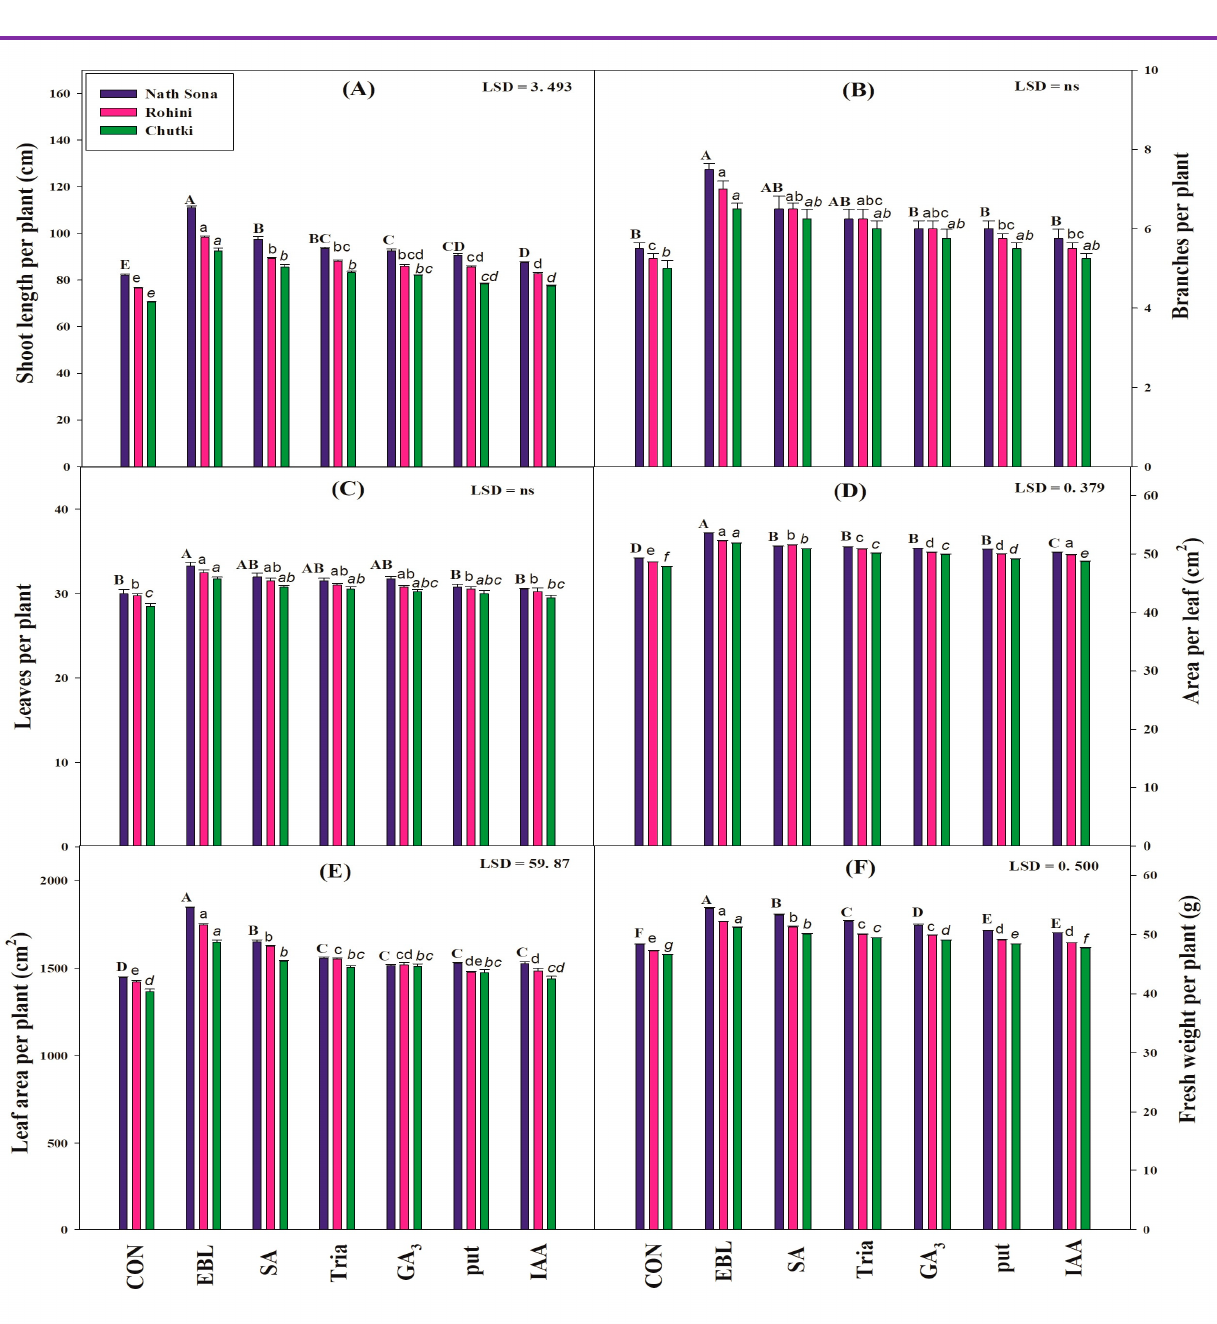
Figure 2. Effect of foliar spray of PGRs on ( A ) Shoot length per plant, ( B ) Branches per plant, ( C ) Leaves per plant, ( D ) Area per leaf, ( E ) Leaf area per plant and ( F ) Fresh weight per plant of the mustard cultivars Nath Sona, Rohini and Chutki. Data are treatment means with the standard error (±SE) of four replicates . The different small and capital letters represent a significant difference in three cultivars among various treatments confirmed through Duncan’s Multiple Range test at p ≤ 0.05.